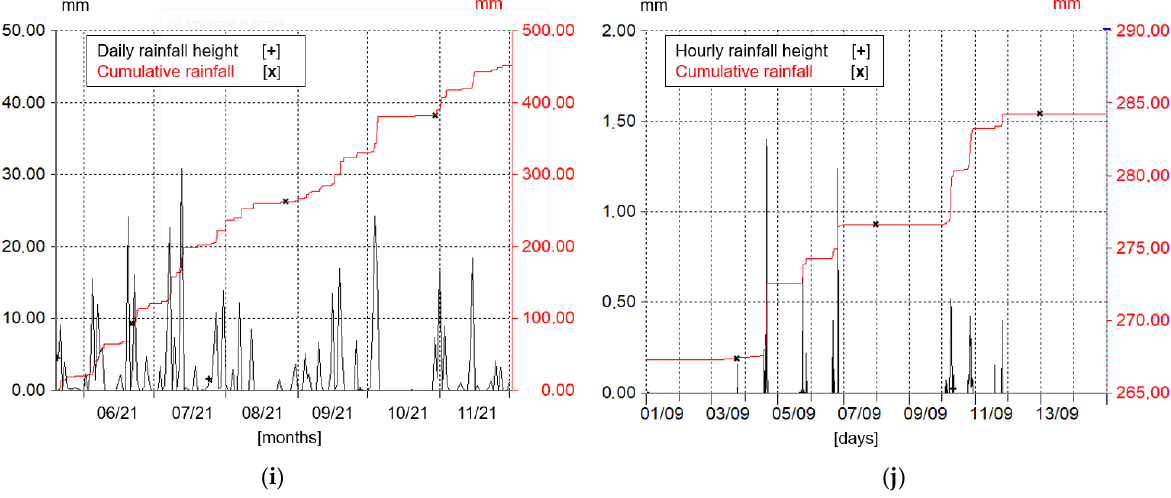
Figure 4. Graphs representing the parameters recorded from weather station sensors (Hydras 3 software layout): ( a , c , e , g , i ) Day mean values; ( b , d , f , h , j ) The real values registered with the time interval of 10 min. For precipitation results, it is plotted are the total daily rainfall height ( i ) and the total hourly rainfall height ( j ) with their cumulative.